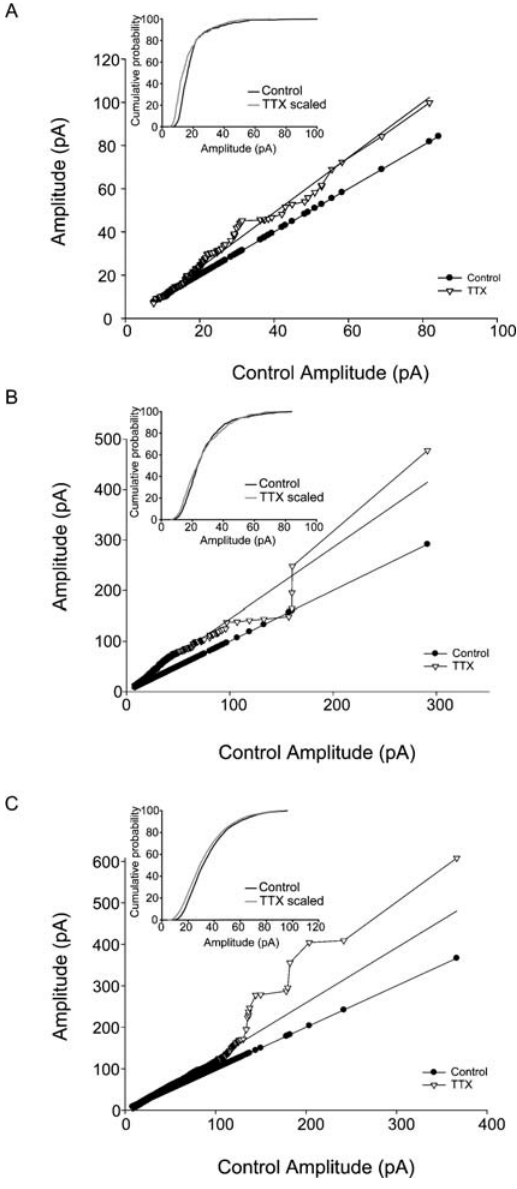
Figure 6. Lack of multiplicative scaling after in vivo TTX-treatment. (A–C) Plots of miniature events, ranked by amplitude, from TTX-treated versus control cells are shown; inserts: cumulative distribution plots of control amplitudes and scaled TTX events (for scaling details see text; scaling factors: juvenile mEPSCs=1.27; adult mIPSCs=1.22; juvenile mIPSCs = 1.33). (A) mEPSCs from juveniles (linear fit equation; TTX=1.27(Cont) 2 2.14; R 2 =0.99). (B) mIPSCs from adults (linear fit equation; TTX=1.22(Cont) + 2.65; R 2 =0.95). (C) mIPSCs from juveniles (linear fit equation; TTX=1.33(Cont) 2 6.77; R 2 =0.97). The scaled-back post-TTX event amplitudes (for details, see main text) remained significantly different from the control amplitudes, indicating lack of multiplicative scaling.